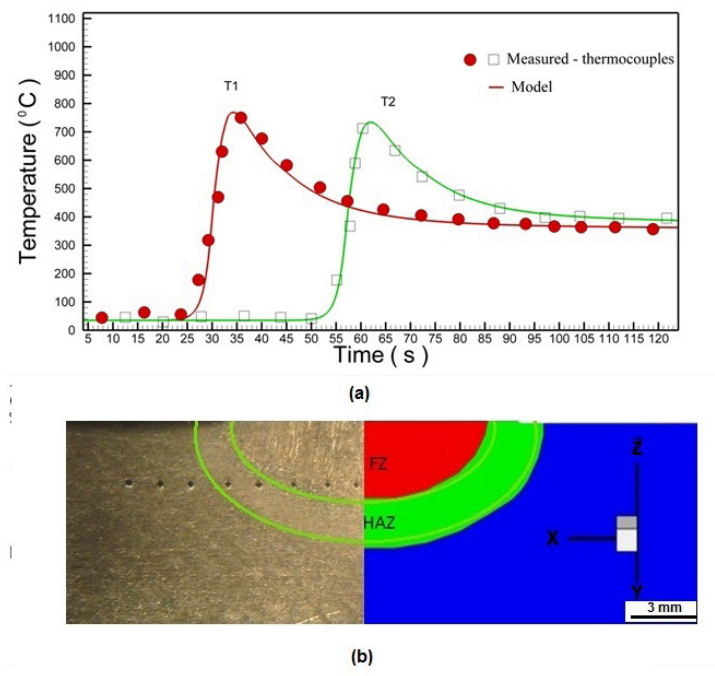
Figure 5 - (a) Comparison for temperature evolution measured by thermocouples located at the bottom and centerline of the weldment and model predictions: Thermocouple (T1) and Thermocouple (T2) at 60 and 120 mm from origin of welding respectively and (b) Numerical and experimental comparison for the fusion zone (FZ) and heat affected zone (HAZ) in a transversal section located at 60 mm in the welding direction. Steel: 0.38%C, 0.96%Mn, 0.22%Si, 0.016%Cu, 0.12%Ni, 0.028%Cr, 0.03%Mo. Plate dimensions 10 x 60 x 220 mm. Heat input 1.5 kJ mm -1 .